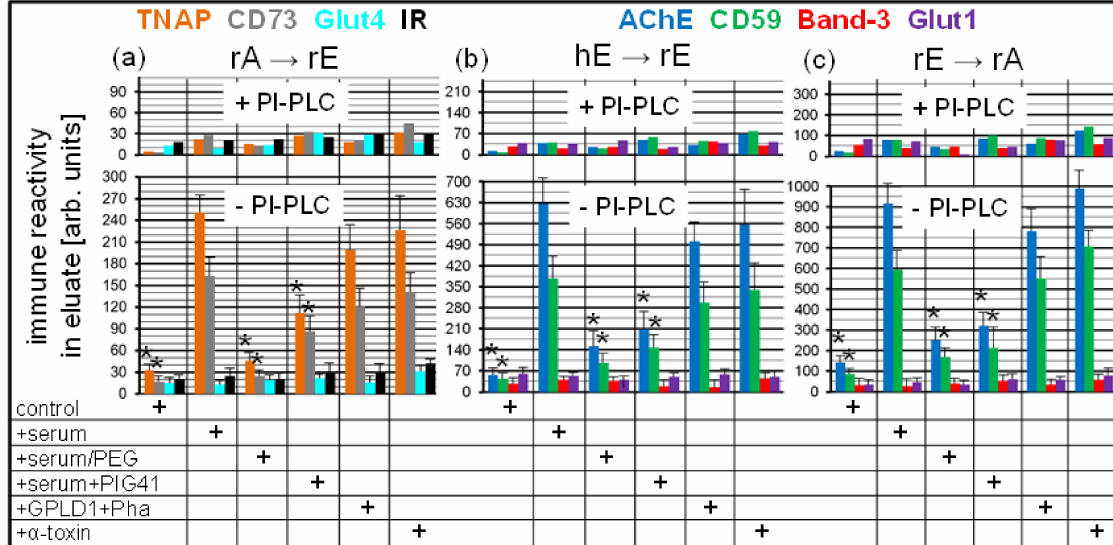
Figure 9. Analysis of the chip eluate for membrane proteins released from the donor PM upon blockade of transfer of full-length GPI-APs to acceptor PM at various combinations. Rat adipocyte ( a ), human erythrocyte ( b ), and rat erythrocyte ( c ) donor PM were injected at 1200 s and at a flow rate of 60 µ L/min into chips with rat erythrocyte ( a , b ) or rat adipocyte ( c ) acceptor PM, respectively, consecutively captured via ionic (Ca 2+ ) and covalent bonds (EDC/NHS), blocked with EtNH 2 and then washed with EGTA/NaCl as described for Figure 8. Thereafter, 100 µ L of washing buffer (control) or serum from obese rats (diluted five-fold with buffer), which had been treated with PEG6000 or left untreated, alone or together with 30 µ M PIG41 or GPLD1 (0.4 units) together with 100 µ M Pha or α -toxin (10 µ g/mL) were injected as indicated. Thereafter, the chips were incubated until 4800 s at 37 ◦ C at flow rate 0. Following injection of 100 µ L of EGTA/NaCl at a flow rate of 60 µ L/min and then of 400 µ L of washing buffer at the same flow rate, the eluate from the chip channels was collected from 4900 to 5300 s and then centrifuged (100,000 × g , 1 h, 4 ◦ C). The supernatants were removed, and halves incubated (2 h, 30 ◦ C) in the absence (lower panels) or presence (upper panels) of PI-PLC as described in the Methods section. Following TX-114 partitioning of the incubation mixtures, the detergent-enriched phases were analyzed for the presence of GPI-APs and transmembrane proteins as indicated by dot blotting with antibodies against TNAP, CD73, AChE, CD59, Glut4, IR, Band-3 and Glut1 as described in the Methods section. “+” below the bars denotes the injection of no serum (control), +serum, PEG-treated serum (+serum/PEG), serum together with PIG41 (+serum+PIG41), GPLD1 together with Pha (+GPLD1+Pha) and α -toxin (+ α -toxin), respectively. The immune reactivities (arb. units) are given as means ± SD (four incubations and elutions each with distinct chips) for each eluted protein (with dot blotting in triplicate) upon normalization by subtraction of unspecific signals generated in the absence of antibody (* p ≤ 0.01 vs. untreated serum